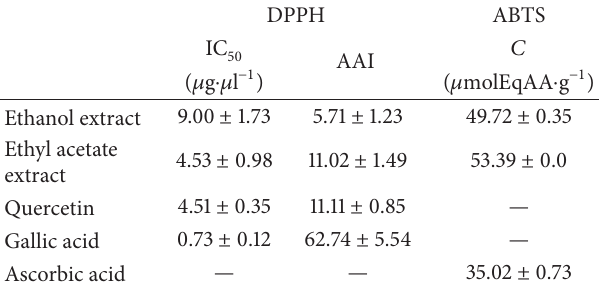
Table 6: Parameters of free radical scavenging activity by DPPH radical and ABTS